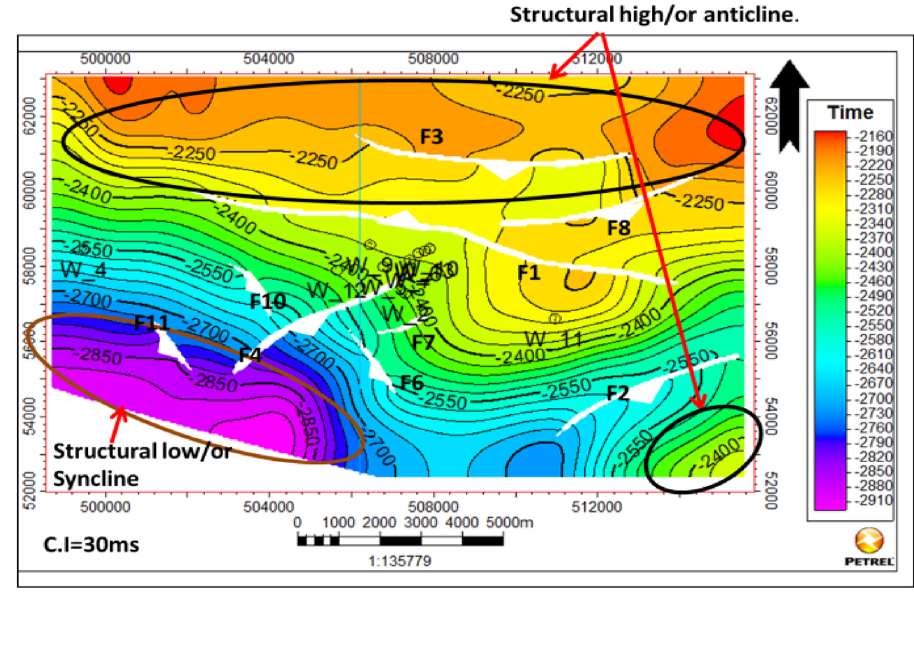
Fig. 4 Composite gamma ray, deep resistivity, and density log readings in reservoir R1, well